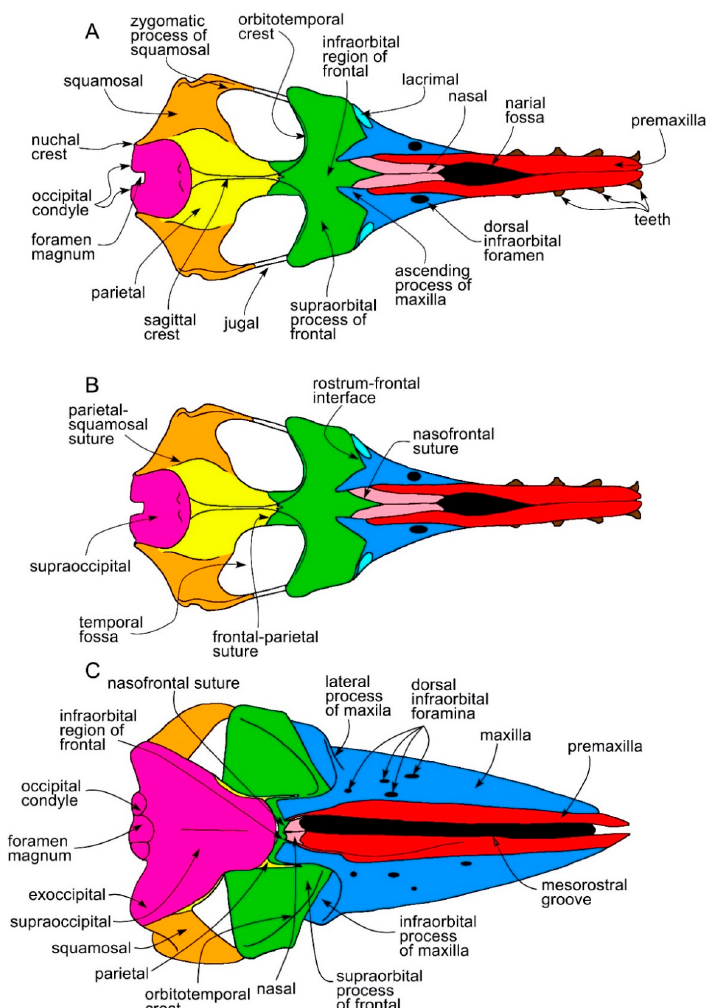
Figure 1. Osteological characters discussed in the text. ( A ) Skull of Dorudon atrox in dorsal view showing the bones forming the cranial vault and the rostrum. ( B ) Skull of Dorudon atrox in dorsal view showing sutures and additional structures. ( C ) Skull of Balaenoptera physalus in dorsal view showing the bones forming the cranial vault, the rostrum and peculiar characteristics of the mys- ticete skull. Not to scale. The skulls were drawn as if they shared the same condylobasal length.